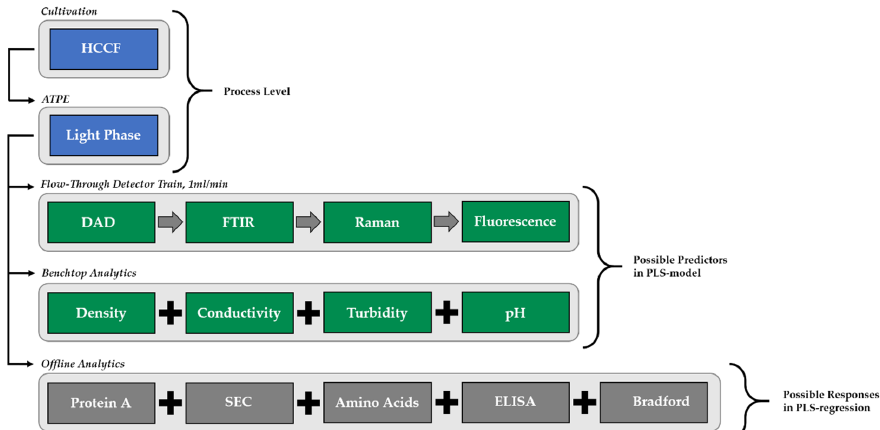
Figure 4. Experimental set-up (blue) and analytical procedure (green). Harvested cell culture fluid (HCCF) is from start (t0) to end of cultivation (t10) processed by aqueous two-phase extraction (ATPE). The antibody containing light phase is pumped in the detector array for spectral analysis and investigated in PLSR as predictors. Offline analytics (grey) are investigated as responses.